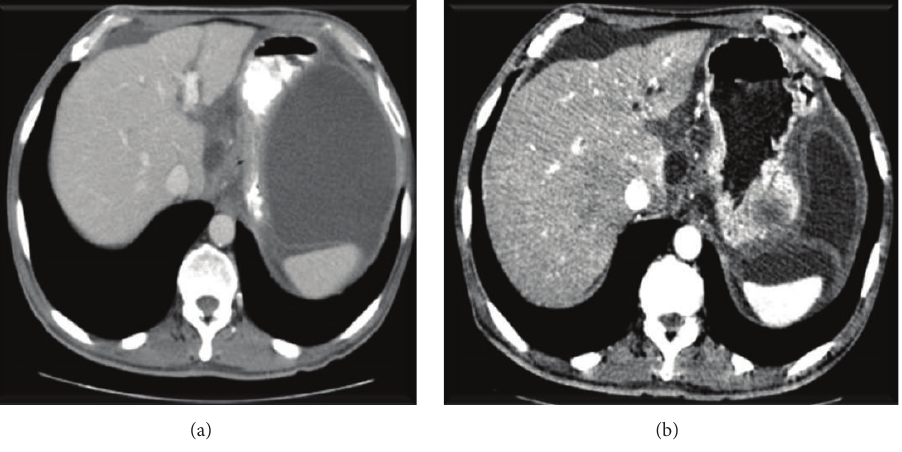
Figure 2: CT scan before and after pseudocyst